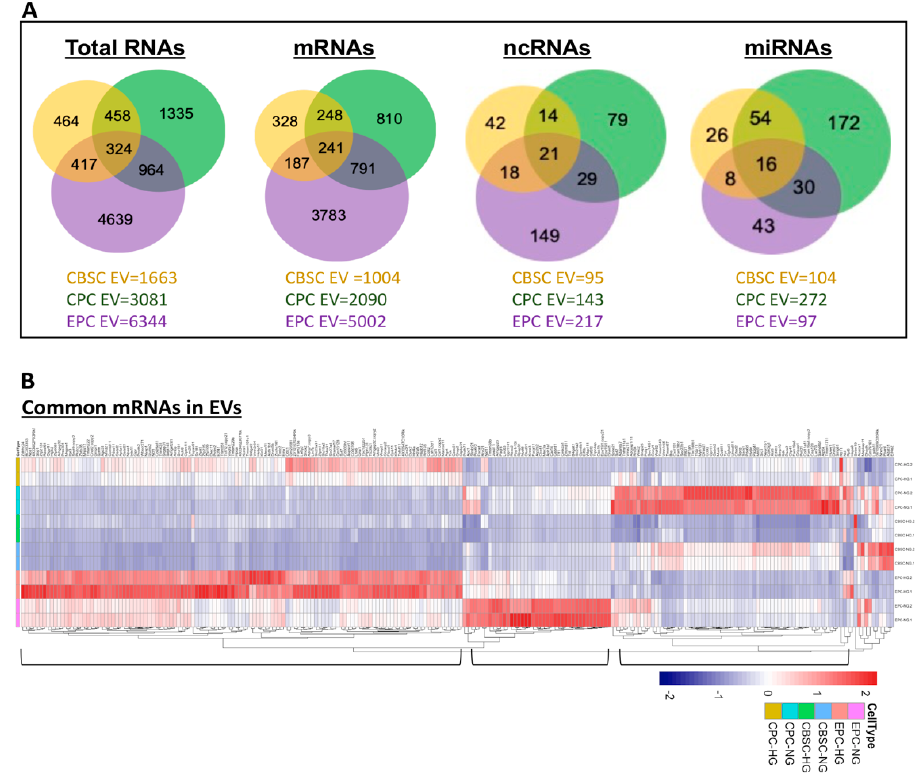
Figure 3. RNA-seq analysis of differentially expressed genes among hyperglycemic EVs. ( A ) Venn diagram representation of differential genes (only FC ≥ 2 and FDR < 5% were considered) of total RNAs, mRNAs, and non-coding RNAs: CBSC- (yellow), CPC- (green), and EPC- (purple) expressed genes, and common genes (grey) are shown. A total 324 genes (241 genes of mRNAs, 21 of ncRNAs, and 16 miRNAs) were presented in all stem cell types. ( B ) Heat maps show differentially expressed mRNAs. EV RNA-seq data were analyzed using DESeq2 package. Red indicates higher expression and blue indicates lower expression (n = 2 mice/group).